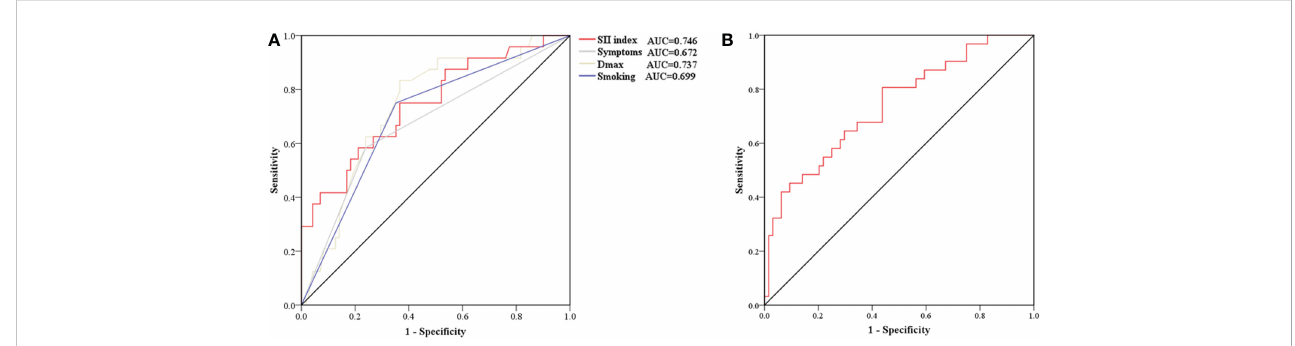
FIGURE 4 Receiver operating characteristic curve for determining the presence of aneurysmal wall enhancement (A) and aneurysmal symptoms (B) . (A) The AUC of the SII index, smoking, and D max were 0.746 (sensitivity 75.0%, speci fi city 63.4%), 0.743 (sensitivity 75.0%, speci fi city 64.8%), and 0.699 (sensitivity 83.3%, speci fi city 63.4%), respectively. (B) The AUC of the SII index was 0.739 (sensitivity 80.6%, speci fi city 56.2%). AUC, area under the curve; D max , maximum diameter; SII, systemic immune-in fl